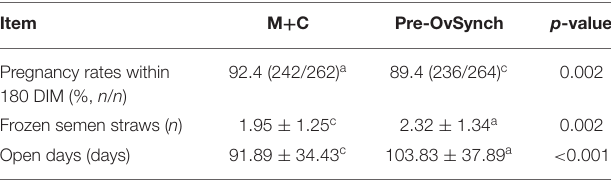
TABLE 2 | The pregnancy rates within 180 DIM, number of frozen semen, and cow open days of the M + C and Pre–OvSynch